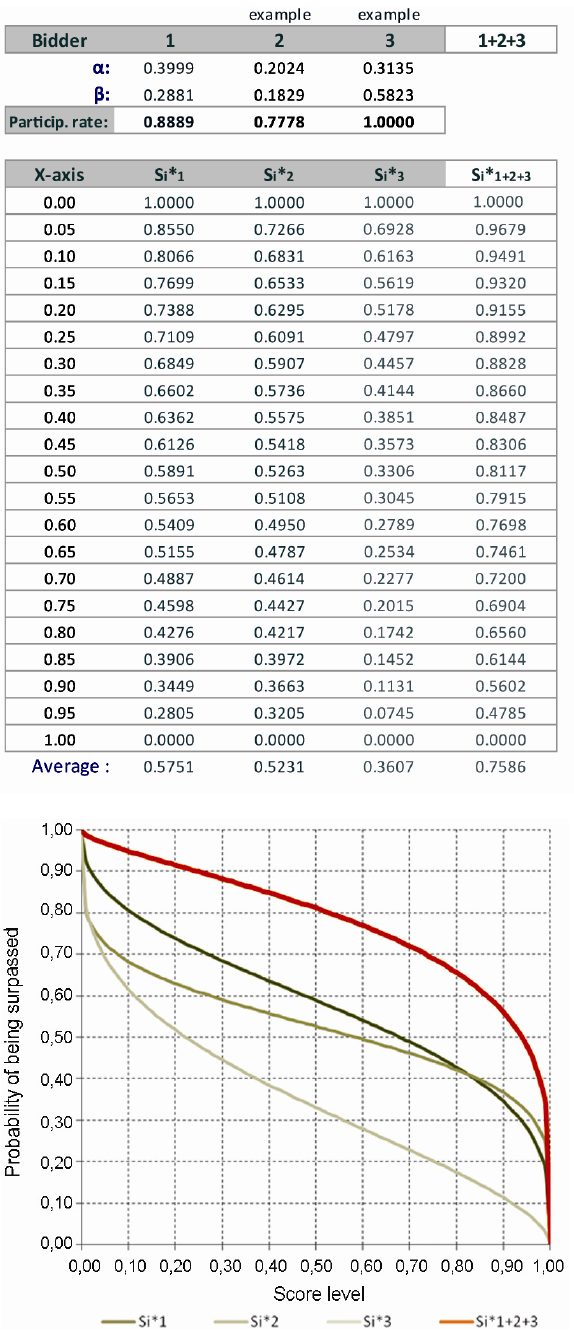
Fig. 4. Scoring performance for several